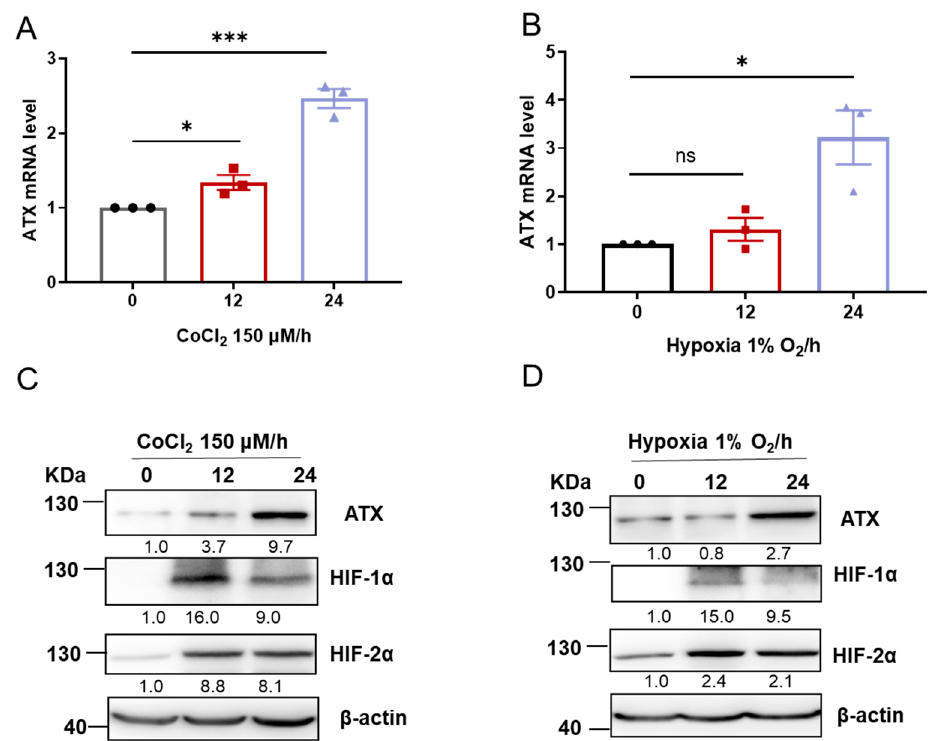
Figure 1. ATX induction by CoCl 2 treatment and hypoxia. ( A , B ) RT-qPCR analysis of ATX mRNA levels in SW480 cells treated with CoCl 2 (150 µ M) ( A ) or exposed to hypoxia (1% O 2 ) for 0, 12, or 24 h ( B ). ( C , D ) Immunoblot assays of ATX, HIF-1 α and HIF-2 α expression levels in SW480 cells treated with CoCl 2 (150 µM) ( C ) or exposed to hypoxia (1% O 2 ) ( D ) for 0, 12, or 24 h. The protein levels were normalized and quanti fi ed by Image J 1.8.0. The data shown are the mean ± SEM of n = 3 independent experiments. p -values were calculated using two-sided unpaired Student’s t tests ( A , B ). ns, not signi fi cant; * p < 0.05; *** p < 0.001.